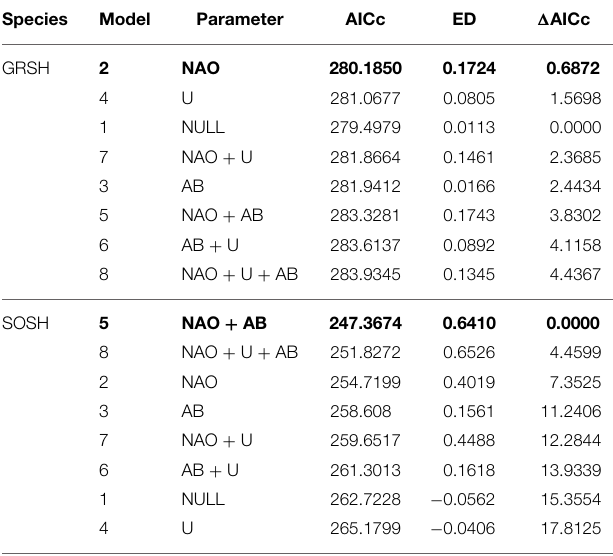
TABLE 2 | Output of Generalized Additive Models showing the ranking of the candidate models based on the corrected Akaike Information Criteria